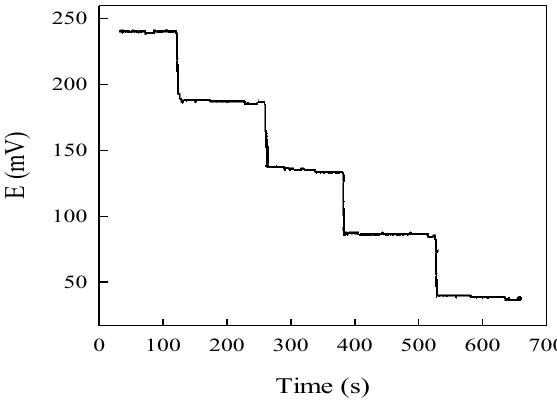
Figure 2. Typical potential-time recorder trace of the electrode based on Hg(BPPPB)Cl Membrane compositions and measurement conditions are given in Table